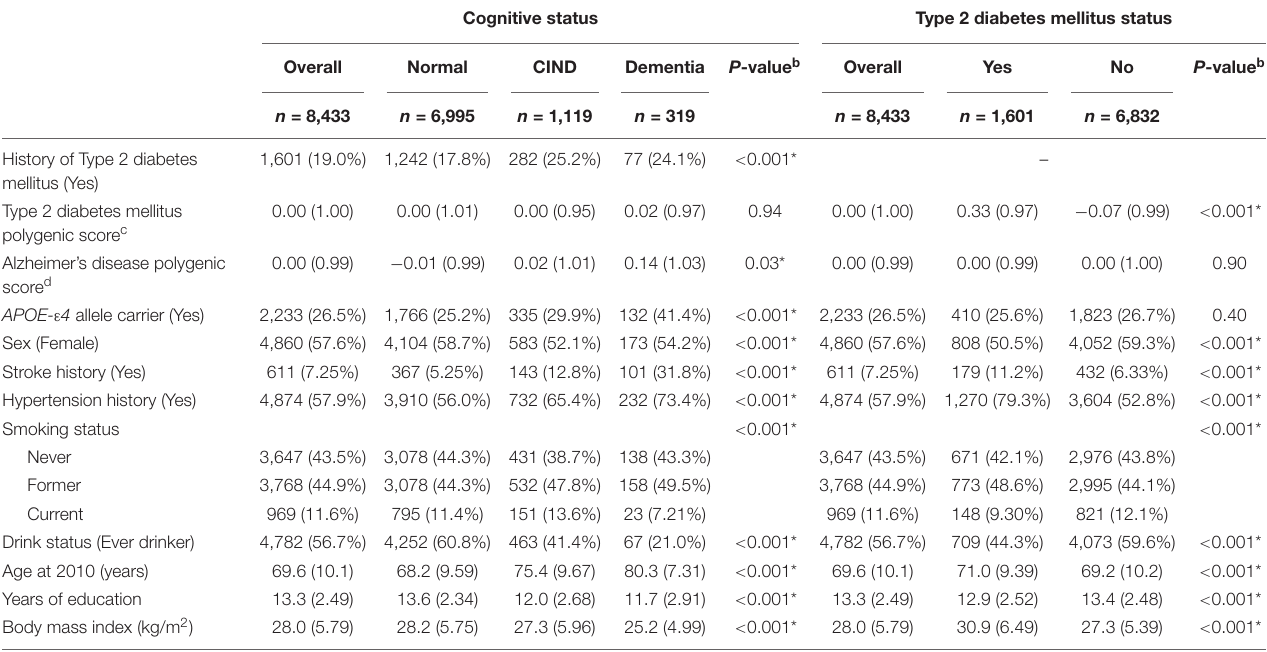
TABLE 1 | Bivariate characteristics stratified by cognitive status or history of Type 2 diabetes mellitus, Health and Retirement Study, Wave 2010, European ancestry sample ( n = 8,433) a .